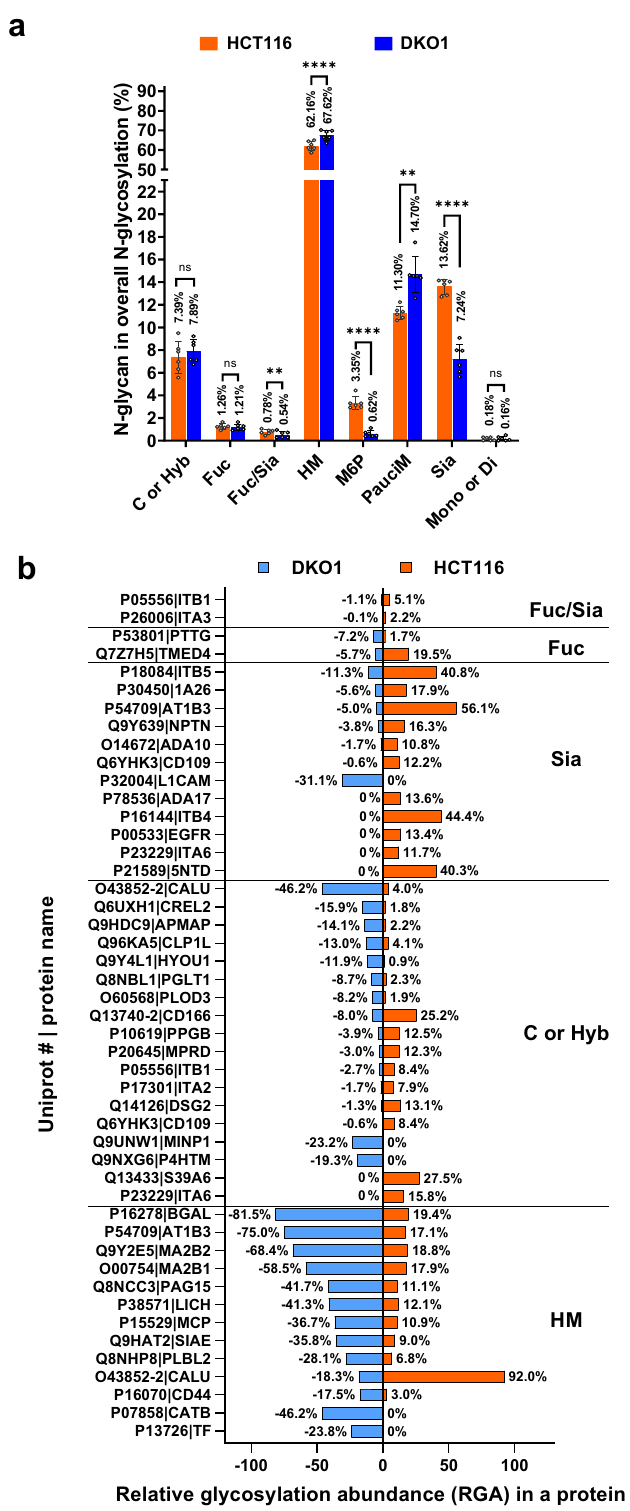
Fig. 4 Comparative analysis of N-glycosylation at the cell level and the protein level. a Distribution of 8 N-glycan classes in HCT116 and DKO1 cells. Data were summarized from 6 MS/MS runs. The PSM of a speci fi c N-glycan class in an MS/MS run was normalized to the total N-glyco PSM of the MS/MS run, and the values in percentage were plotted to the y -axis. ns: not signi fi cant; **, P ≤ 0.01; ****, P ≤ 0.0001, mean with SD, t-test, two-tailed, n = 6. b The N-glycoproteins with signi fi cant differences in high mannose N-glycans (HM), complex or hybrid N-glycans (C or Hyb), Sialylated N-glycans (Sia), Fucosylated N-glycans (Fuc), or Fucosylated and Sialylated N-glycans (Fuc/Sia) in HCT116 and DKO1 cells. The glycan ratio between HCT116 and DKO1 is ≥ 3. The relative glycosylation abundance (RGA) of N-glycans in DKO1 is presented with a negative symbol as a result of the plotting method. Ignore the negative sign and read the absolute value. A more detailed analysis can be found in Supplemental Data